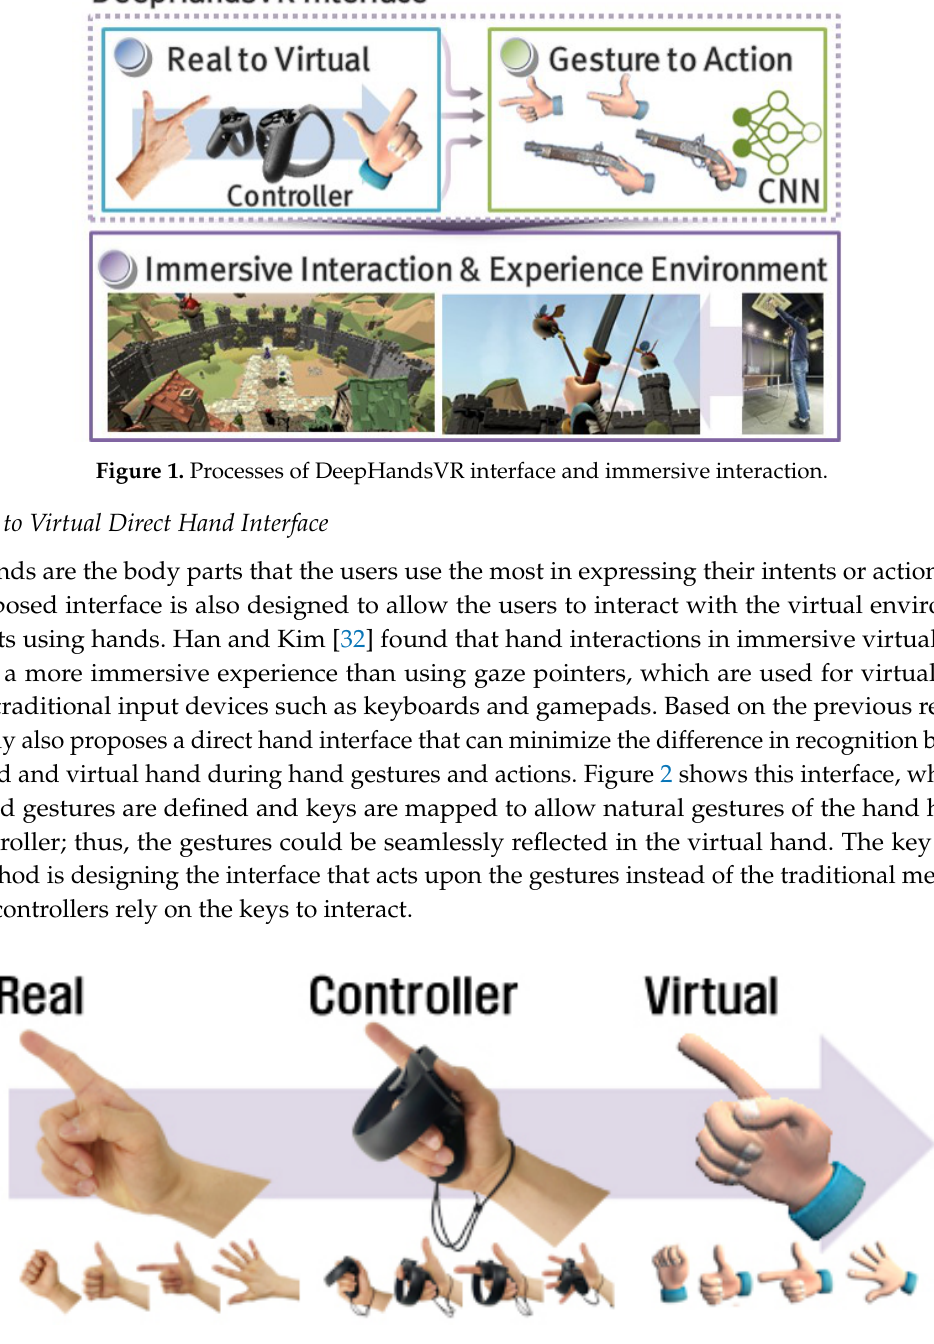
Figure 2. Real-to-virtual direct hand interface